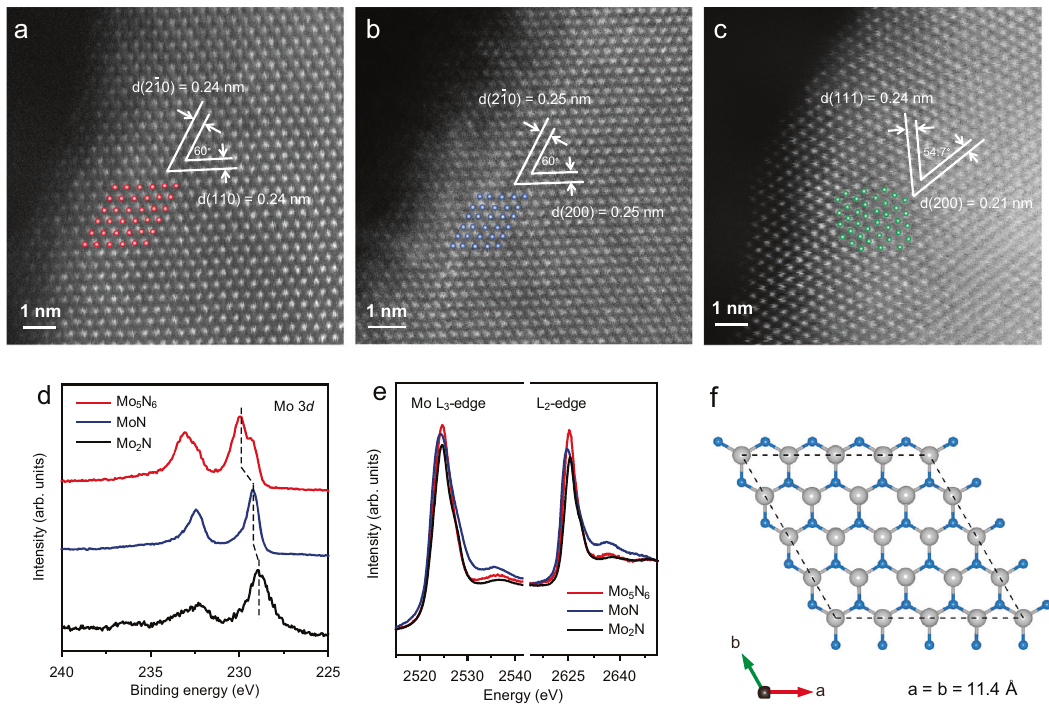
Fig. 1 Atomic and electronic structural characterization of Mo 5 N 6 , MoN and Mo 2 N. a – c HAADF-STEM images of Mo 5 N 6 , MoN, and Mo 2 N. Insets are schematics of Mo con fi gurations in which red-color, blue, and green spheres represent Mo atoms in Mo 5 N 6 , MoN and Mo 2 N, respectively. d , e Mo 3 d XPS and Mo L 3 , L 2 -edge NEXAFS spectrum for Mo 5 N 6 , MoN, and Mo 2 N. f Computational model for Mo 5 N 6 (0 0 4). The gray and light-blue spheres represent Mo and N atoms,